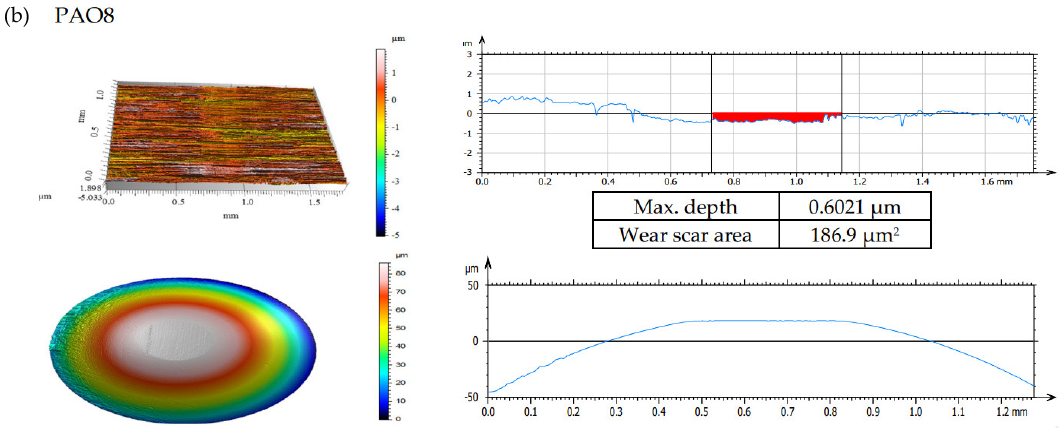
Figure 6. Isometric views and primary profiles of the discs and balls after the tribological tests of PAO8 on TRB 3 tribotester equipped with ( a ) disc coated by a-C:H and ( b ) uncoated disc.